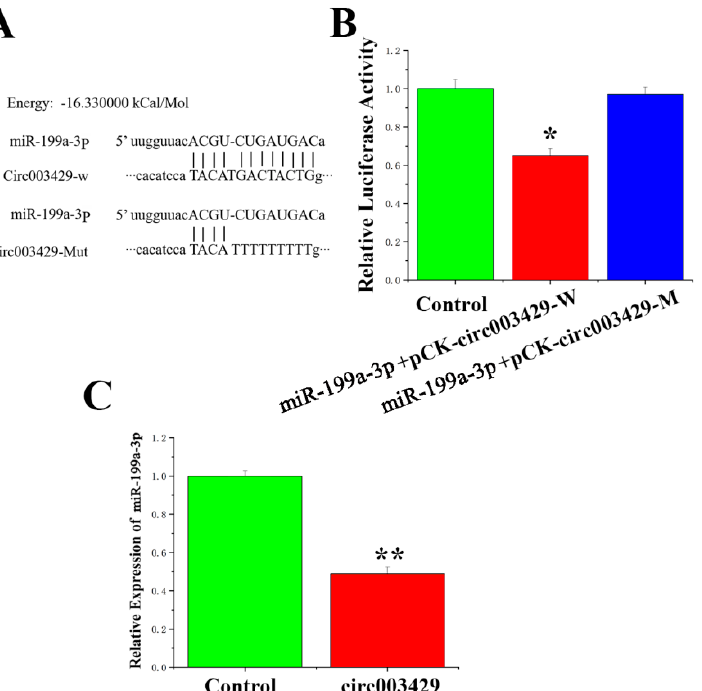
Figure 6. Analysis of the relationship between circ003429 and miR-199a-3p. ( A ) Sequence analysis of the binding site of miR-199a-3p and circ003429. ( B ) miR-199a-3p was cotransfected with pCK- circ003429-W or pCK-circ003429-Mut in 293T cells. ( C ) Effect of circ003429 on the expression levels of miR-199a-3p. Values are shown as the means ± standard errors. * p < 0.05; ** p < 0.01.